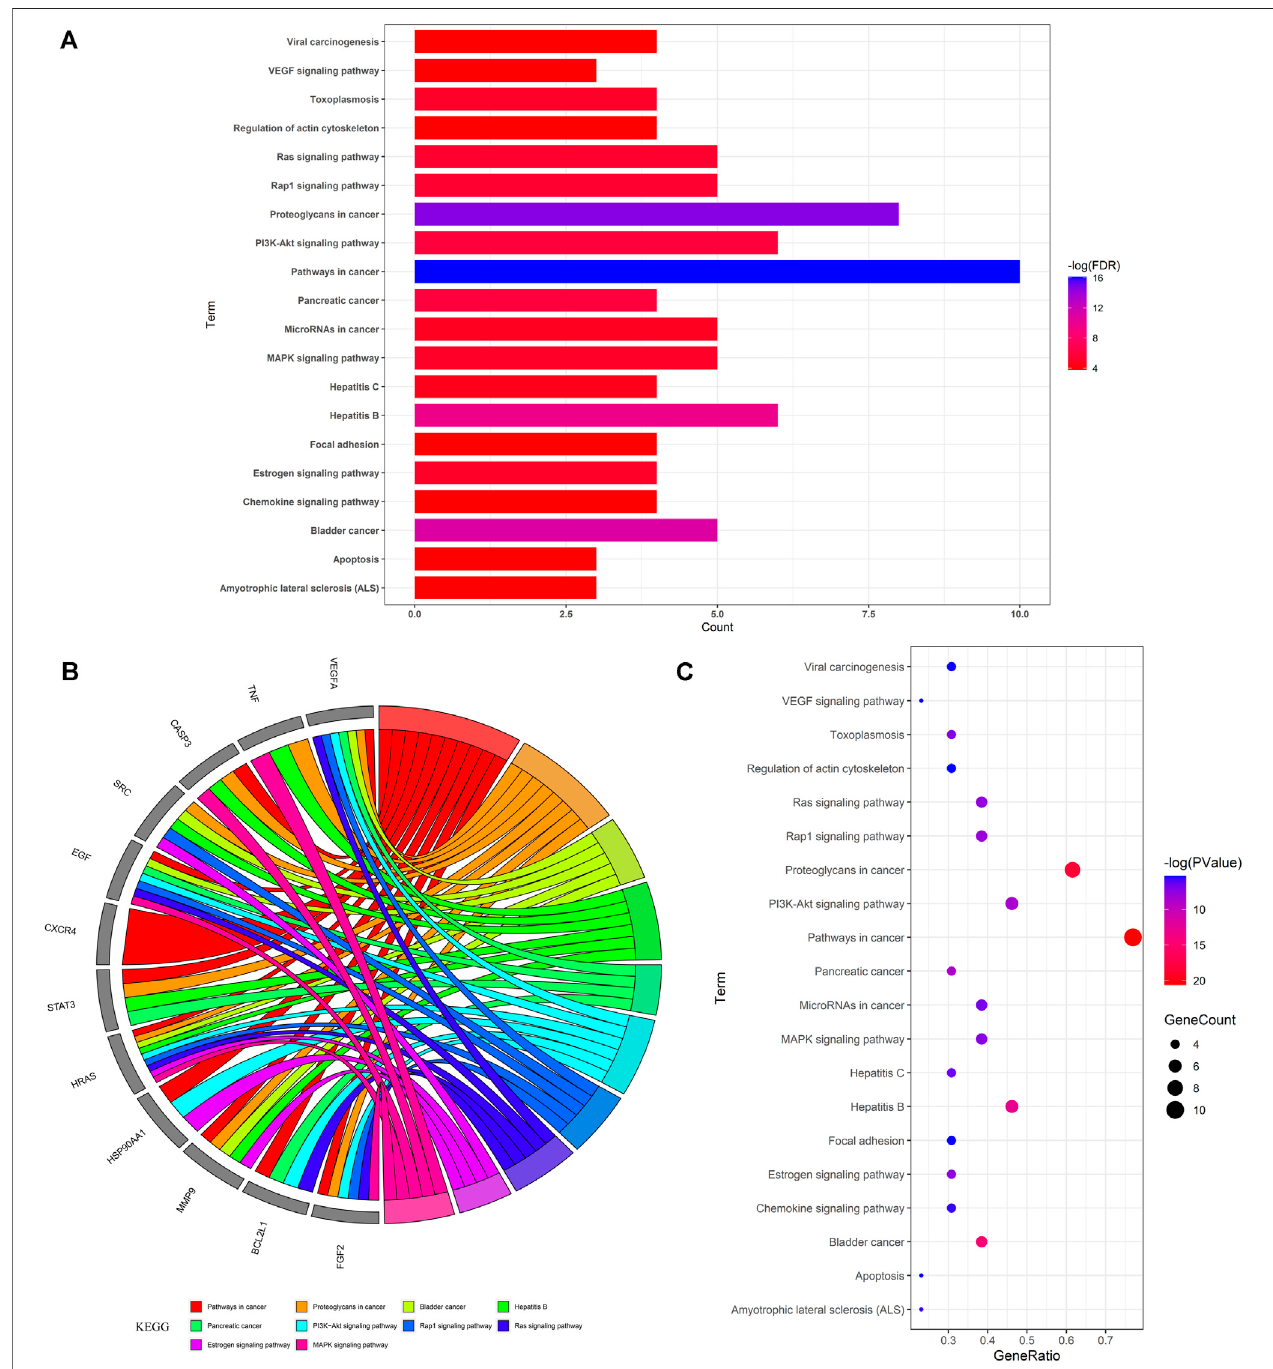
FIGURE 4 | KEGG-based enrichment analysis for revealing the top 20 molecular pathways of Pachyman in treating HCC as shown in bar chart (A) , circle diagram (B) , bubble graph (C) .